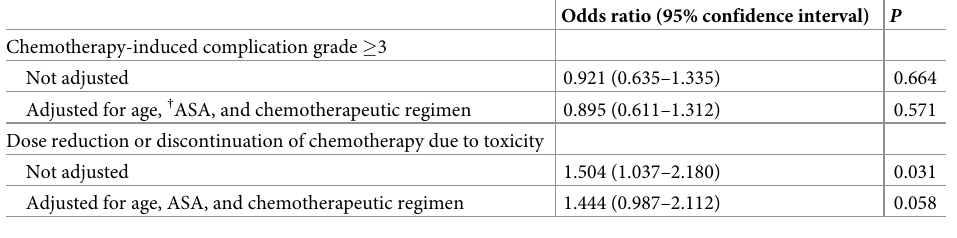
Table 3. Odds ratios for patients who initiated chemotherapy beyond 20 days relative to within 20 days after